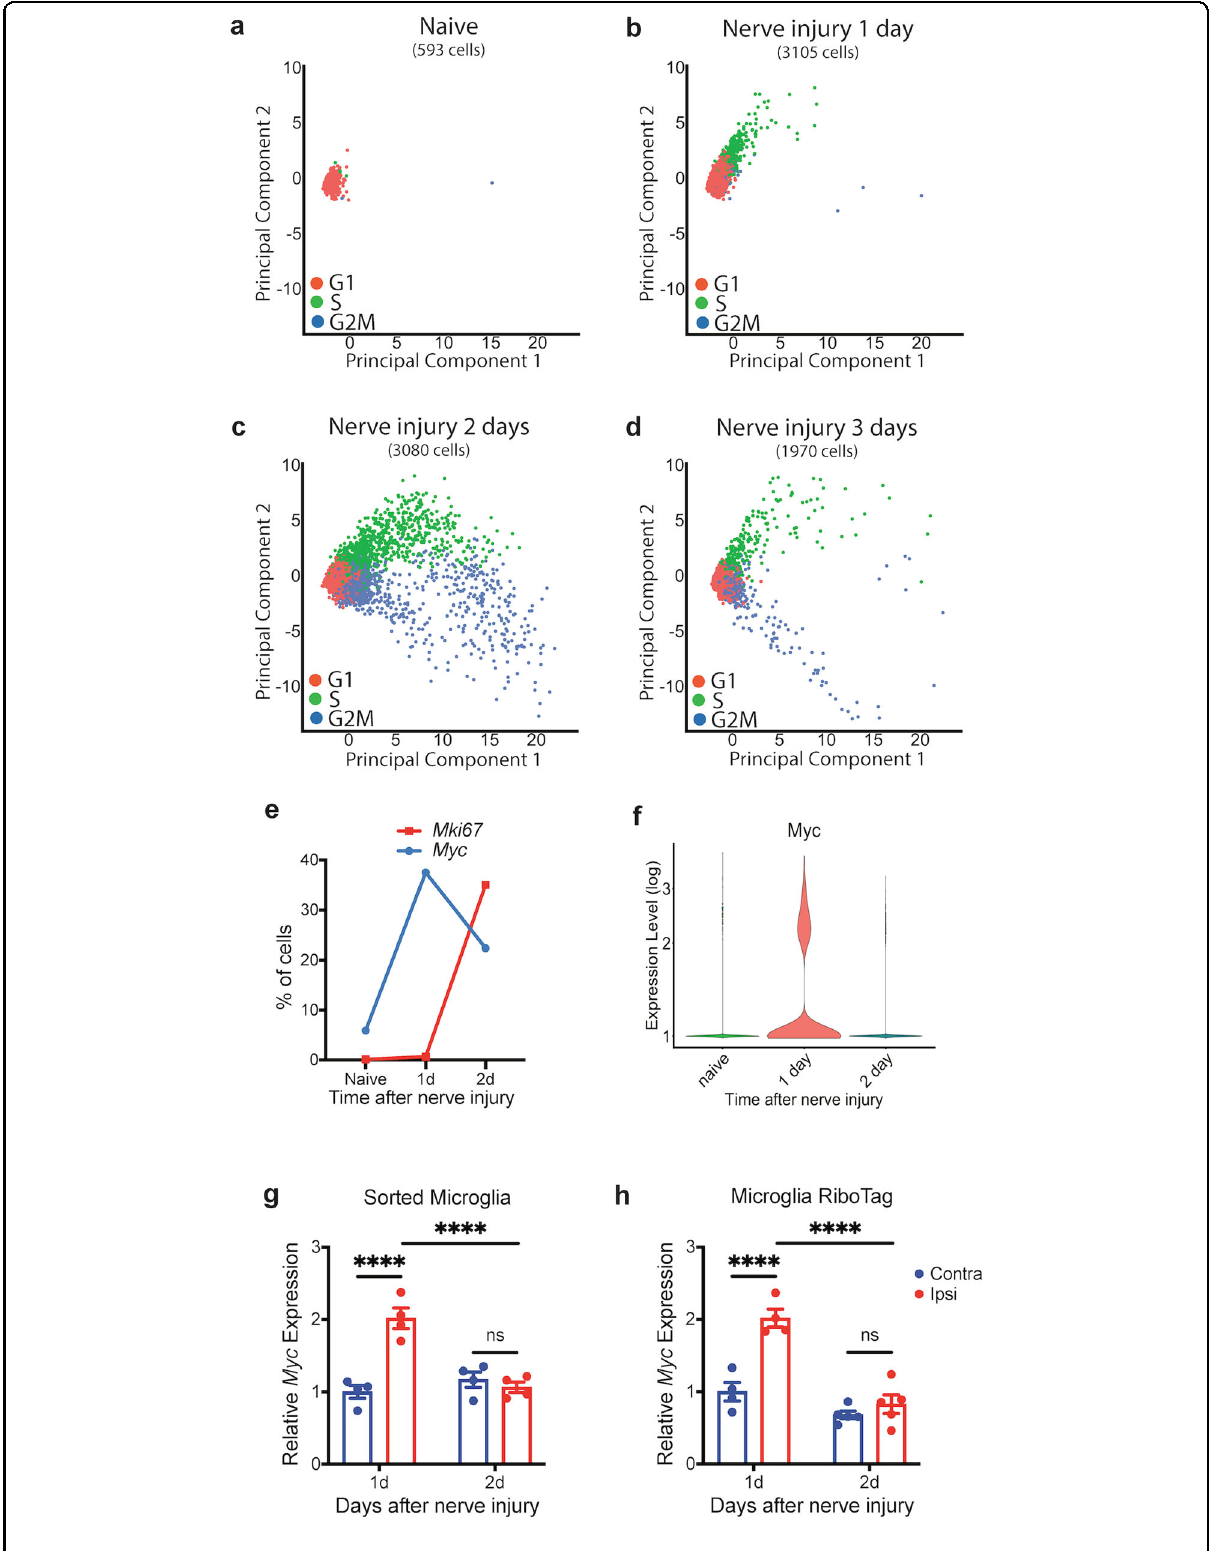
Fig. 1 (See legend on next